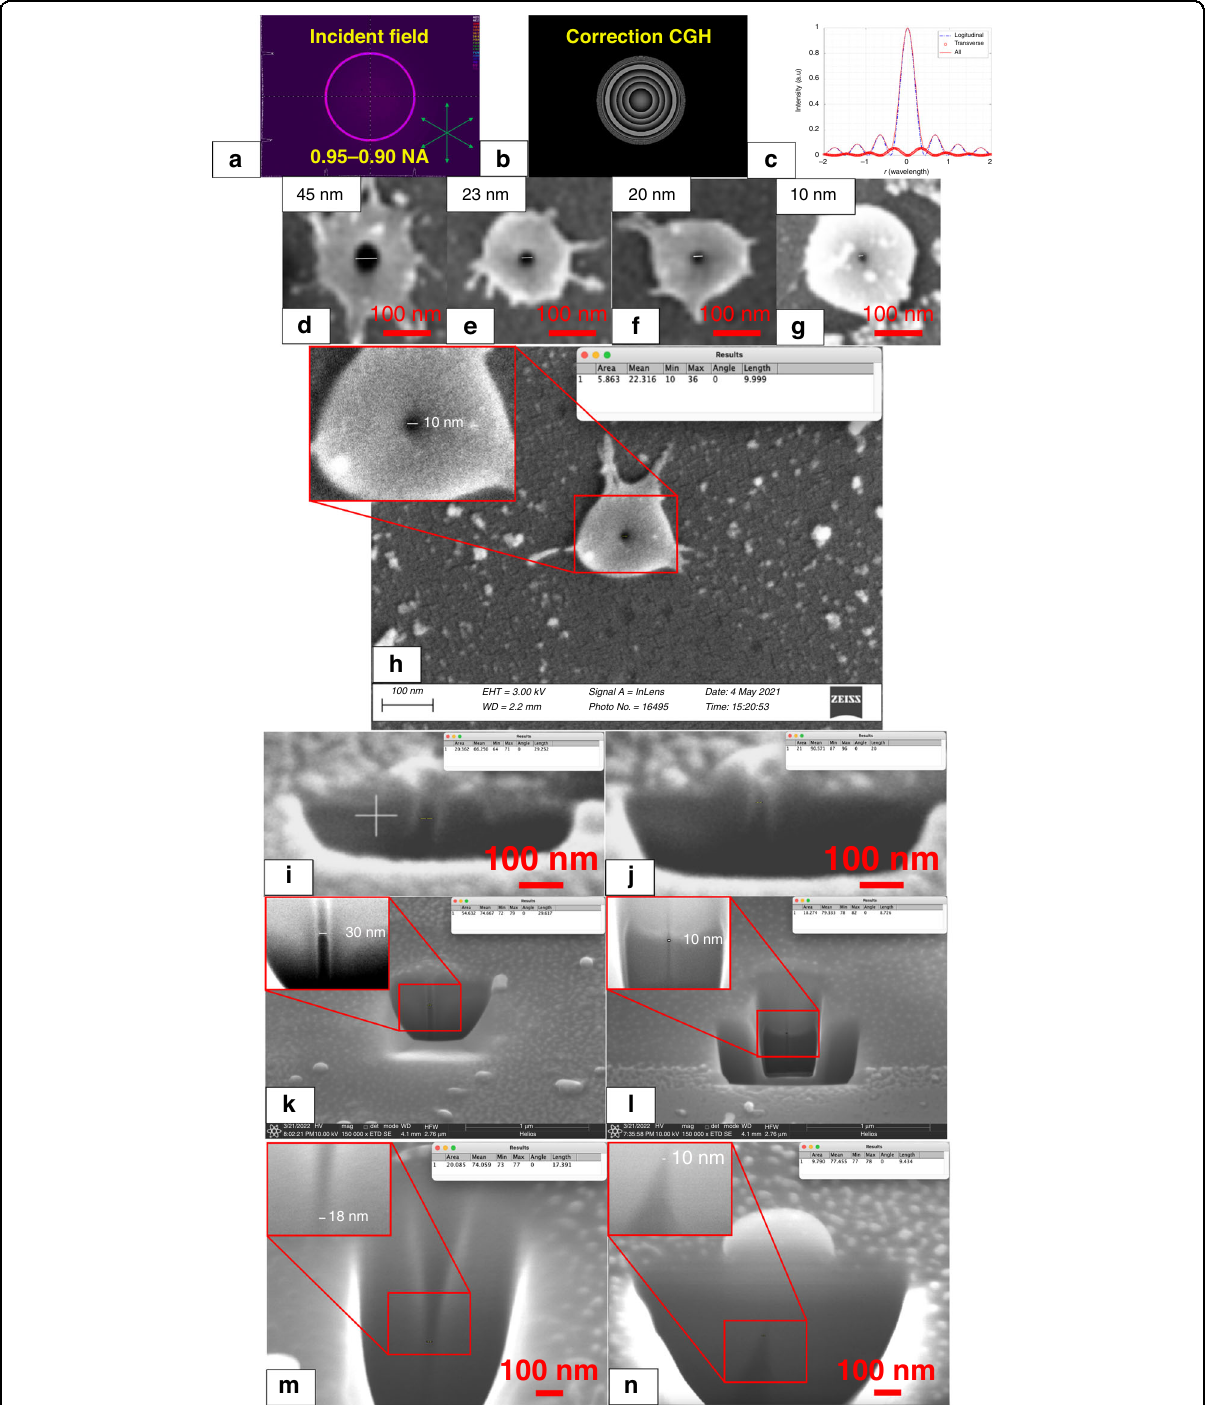
Fig. 5 Effect of optimised longitudinal laser beam hole drilling on sapphire realising 10-30 nm hole size with high depth to width aspect ratio. a Intensity distribution of the radial polarisation annular beam based on apodization function measured before objective lens by using a beam pro fi ler, b CGH for spherical aberration correction, c light fi eld modelling for focusing radial polarisation with 0.95 – 0.90 NA objective lens, d – h effect of single pulse ablation based on laser beam with radial polarisation on polished sapphire with gradually reduced pulse energy, i and j the cross- section of holes with diameters of 30 and 20 nm, k the cross-section of a hole with no taper with a diameter of 30 nm and a depth of 500 nm, l the cross section showing a diameter of 8.7 nm extending to a depth of over 700 nm, m the cross-section of a hole with positive taper with a diameter down to 15.1 nm at the bottom area of taper, n the cross-section of a negative taper with a diameter down to 9.4 nm at the top area of